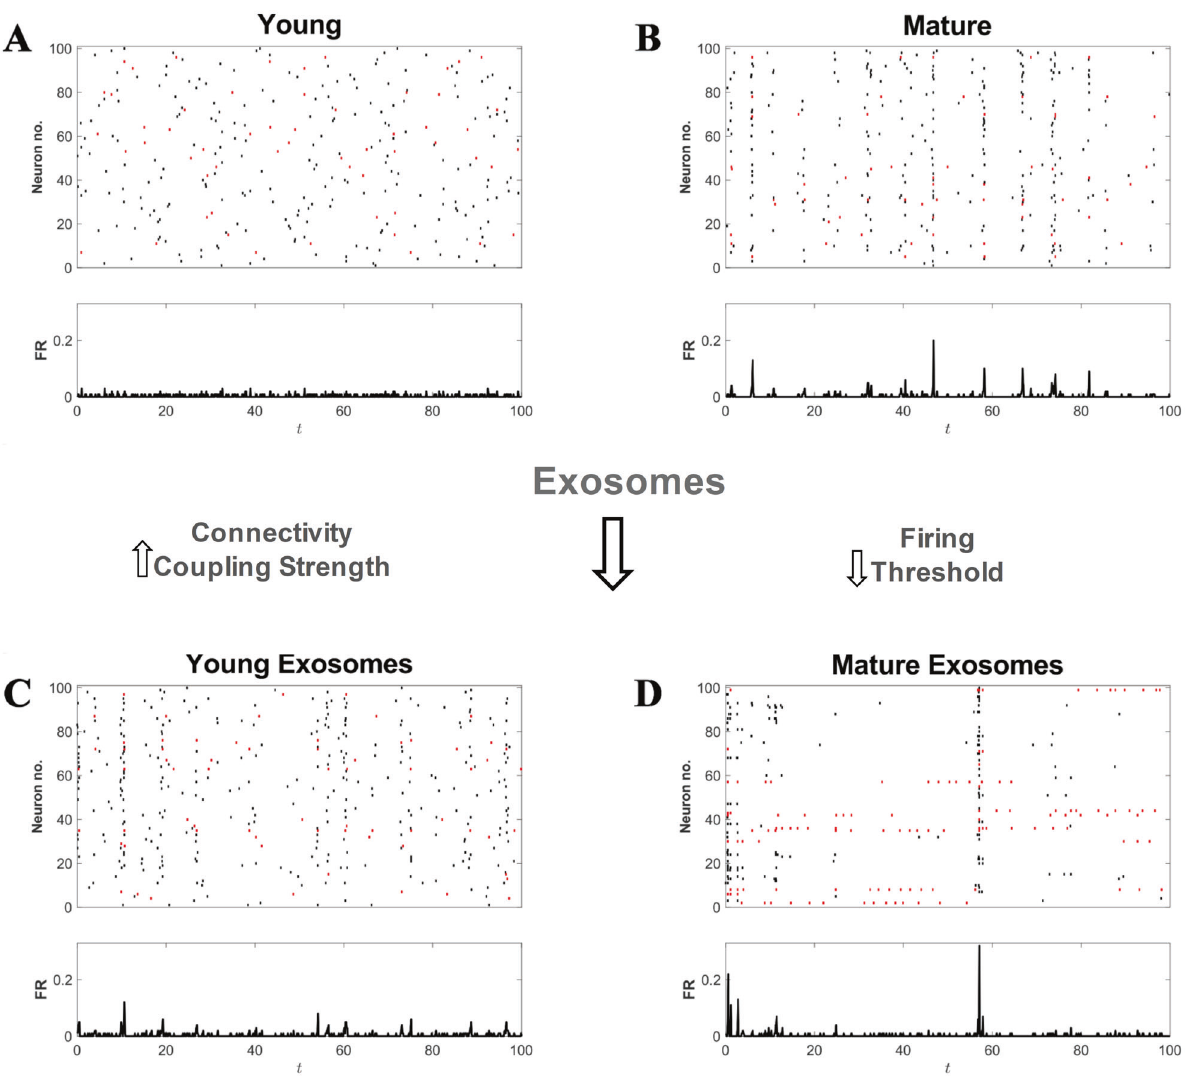
Fig. 8 Mechanisms for synchrony and its disruption. The raster plots and the fi ring rate of in-silico neuronal cultures are plotted for young and mature cultures in the absence and in presence of exosomes. Young immature cultures ( A ) are modeled by a sparse network with low coupling, which is unable to produce consistent population spikes, whereas mature cultures are modeled by a network with strong coupling, leading to the emergence of population spikes ( B ). The presence of exosomes is modeled according to the experimental evidence. For young cultures, the presence of exosomes is modeled by an increase in connectivity and an increase in the strength of the synaptic coupling ( C ), which allows for the appearance of population spikes, as observed in our experiments. For mature cultures ( D ) the presence of exosomes is modeled by decreasing the neuronal threshold for fi ring. This leads to a fi ring-inhibition regime, with reduced fi ring and only rare population events. Due to the large coupling, population events may now recruit large portions of the network. The leaky integrate and fi re model used for these in-silico realizations are described in detail in the SI where we provide the meaning and interpretation of the different parameters used in the simulations. The young culture in panel A is simulated by setting the model parameters to d c = 0.25, V th = 2.0 mV, σ = 10.0 pA and I 0 = 6.0 pV. The presence of exosomes (panel C ) in this case was modeled by increasing the connectivity ( d c = 0.25) and the coupling ( σ = 130.0 pA). The mature culture in panel ( B ) is simulated by setting the model parameters to d c = 0.5, V th = 3.0 mV, σ = 180.0 pA and I 0 = 10.0 pA. The presence of exosomes was modeled by V th = 0.50 pA (panel D ). All the panels are obtained from in-silico neuronal networks of N = 100